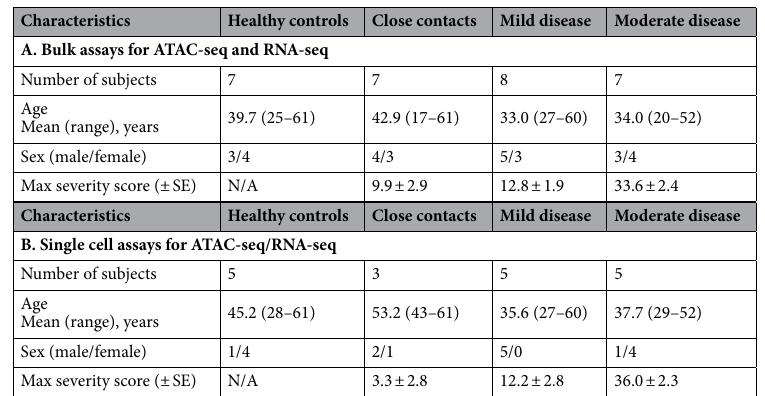
Table 1. Demographic characteristics and mean symptom severity scores of study